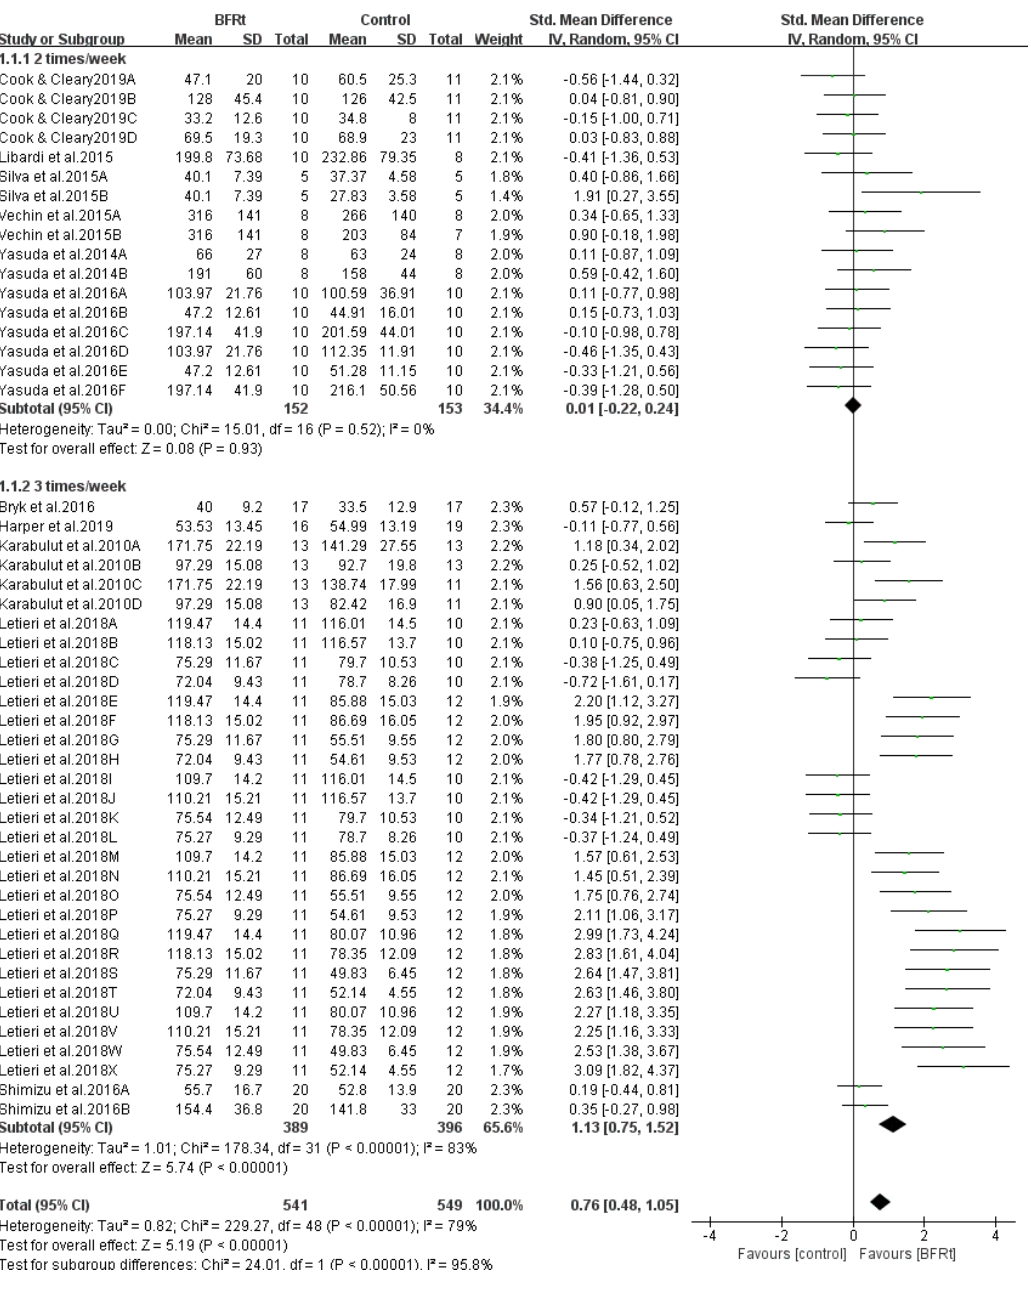
Figure 6. Subgroup analysis of the effect of BFRt training frequency on lower-limb muscle strength. Different letters for the same study represent different muscle strength assessment methods [19,22,29–37].